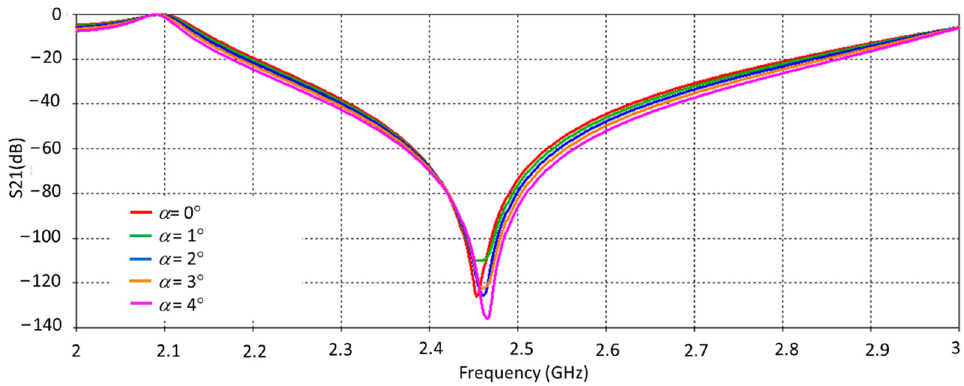
Figure 10. Effect of the mode stirrer axis ’ s inclination ( α ) from its ideal position.